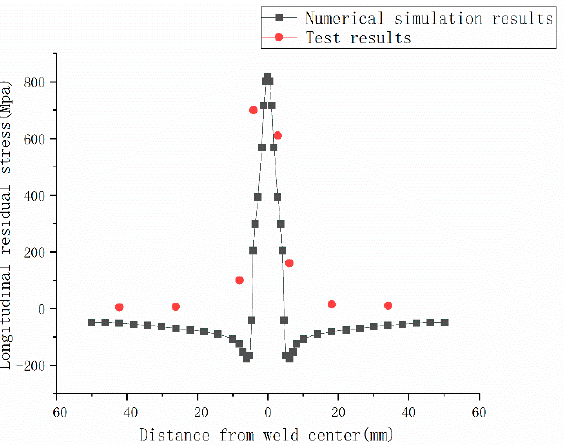
Figure 10. Comparison between simulation and test results of longitudinal residual stress along vertical weld path.